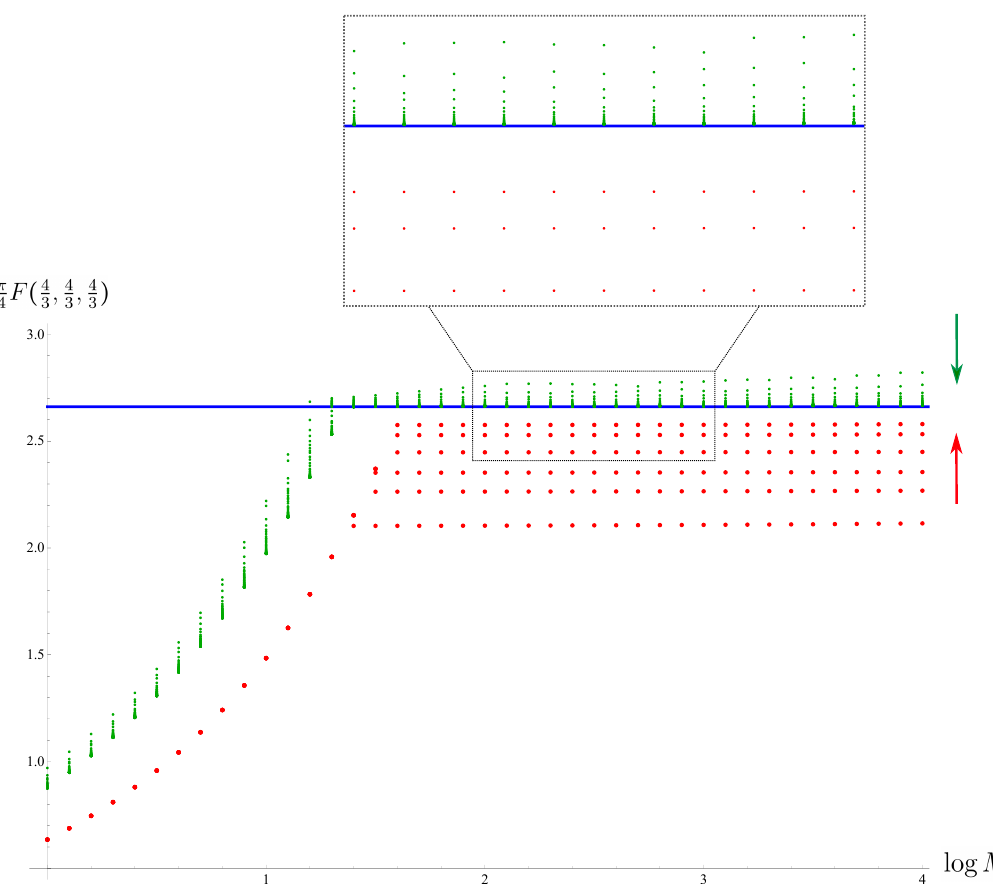
Figure 3. The maximum of the amplitude at the symmetric point s 0 = t 0 = u 0 = 4 regulator M reg is increased for the primal (red) and dual (green) problems. The horizontal axis gives the regulator in a logarithmic scale and up to a horizontal shift to plot the curves together. As explained in the main text, the primal improves by increasing the number of interpolation points, as indicated with the red upward arrow, and the dual improves by increasing the number of coefficients, as indicated with the green downward arrow. We do not asume the existence of a pole at threshold which would give the horizontal blue line. The values are multiplied by a factor π/ 4 to match the normalization in the literature, e.g.